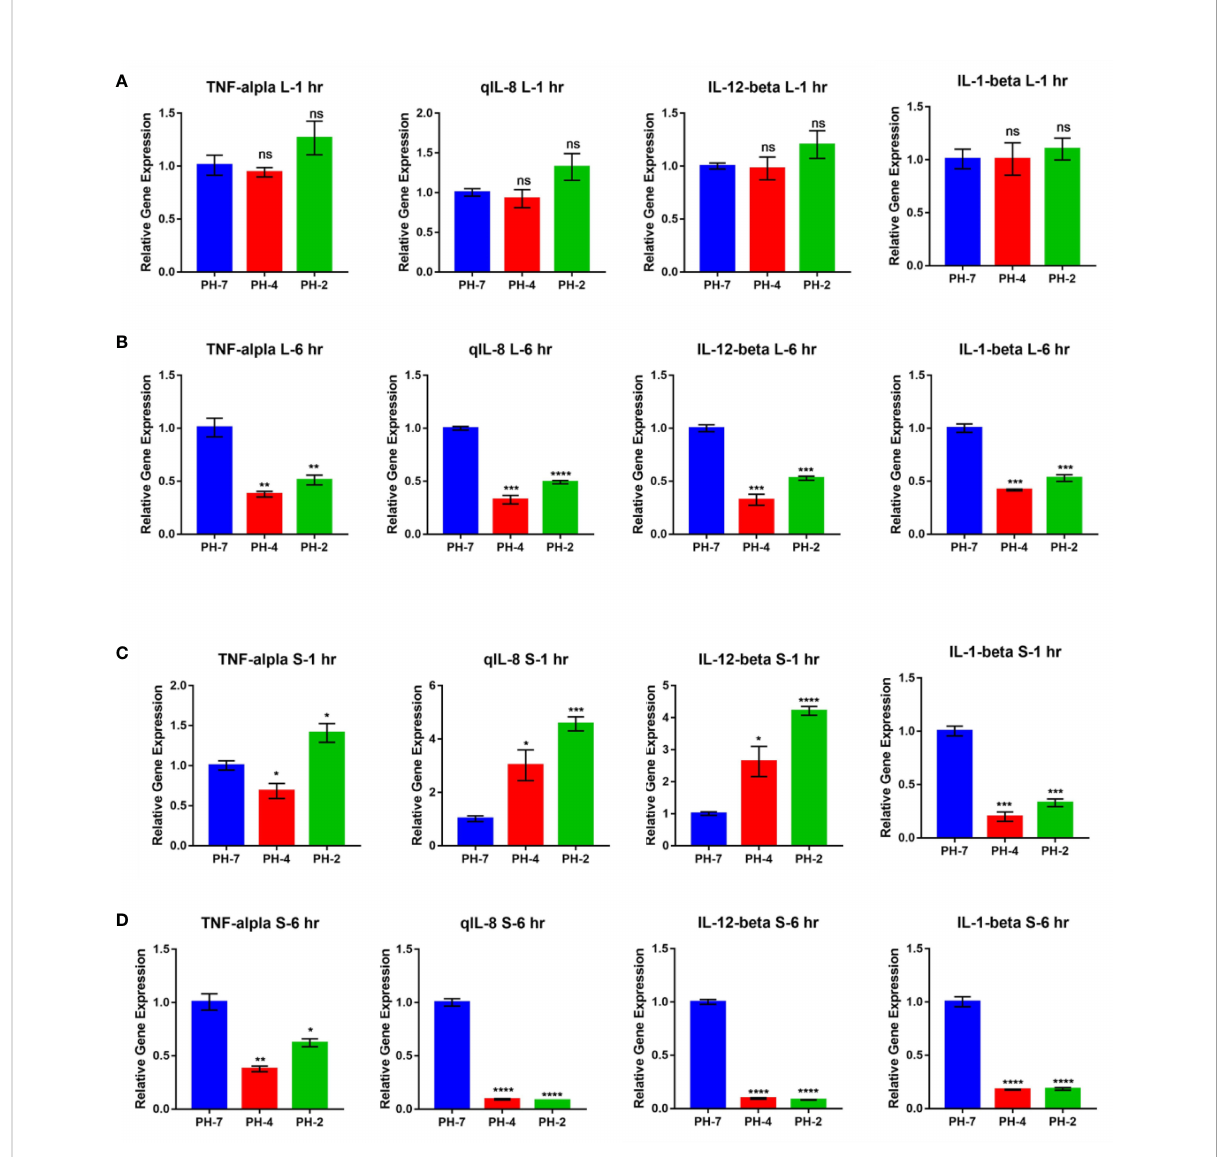
FIGURE 6 O. niloticus spleen and liver immune gene expression under pH 2, 4 and 7 at 1 hr and 6 hr. (A) Liver gene expression after 1 hr. (B) Liver gene expression after 6 hr. (C) Spleen gene expression after 1 hr. (D) Spleen gene expression after 6 hr. * means p< 0.05, ** means p< 0.01, *** means p< 0.005, **** means p< 0.001. ns means not signi fi